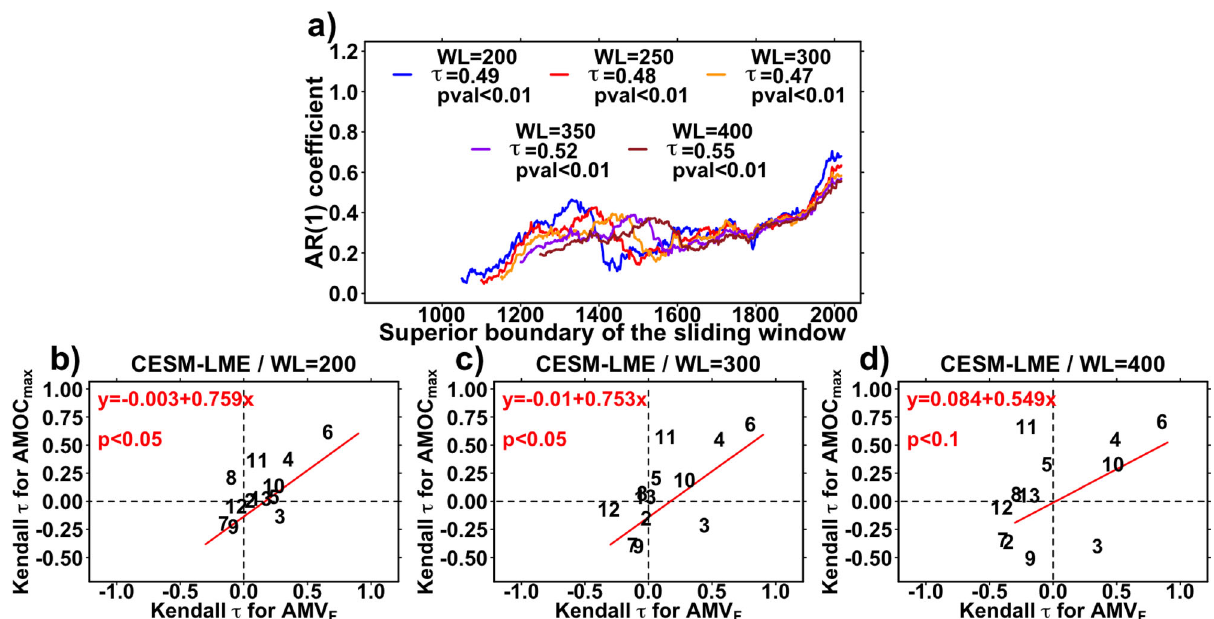
“ Methods ” ). b – d EWS statistics in CESM-LME simulations. Kendall τ statistics obtained for the maximum Atlantic Meridional Overturning Circulation strength below 500 meters depth (AMOC max ) AR(1) coef fi cients (ordinates) are plotted against the Kendall τ statistics obtained forthe AMV F AR(1) coef fi cients (abscissas) for WL=200 ( b ), WL=300 ( c ), and WL=400 ( d ), respectively. Plotted numbers indicate the member index of the CESM-LME simulations (from 2 to 13). Red lines are the ordinary least squares regression lines, and their signi fi cance is calculated using a two-tailed Student t test of the regression